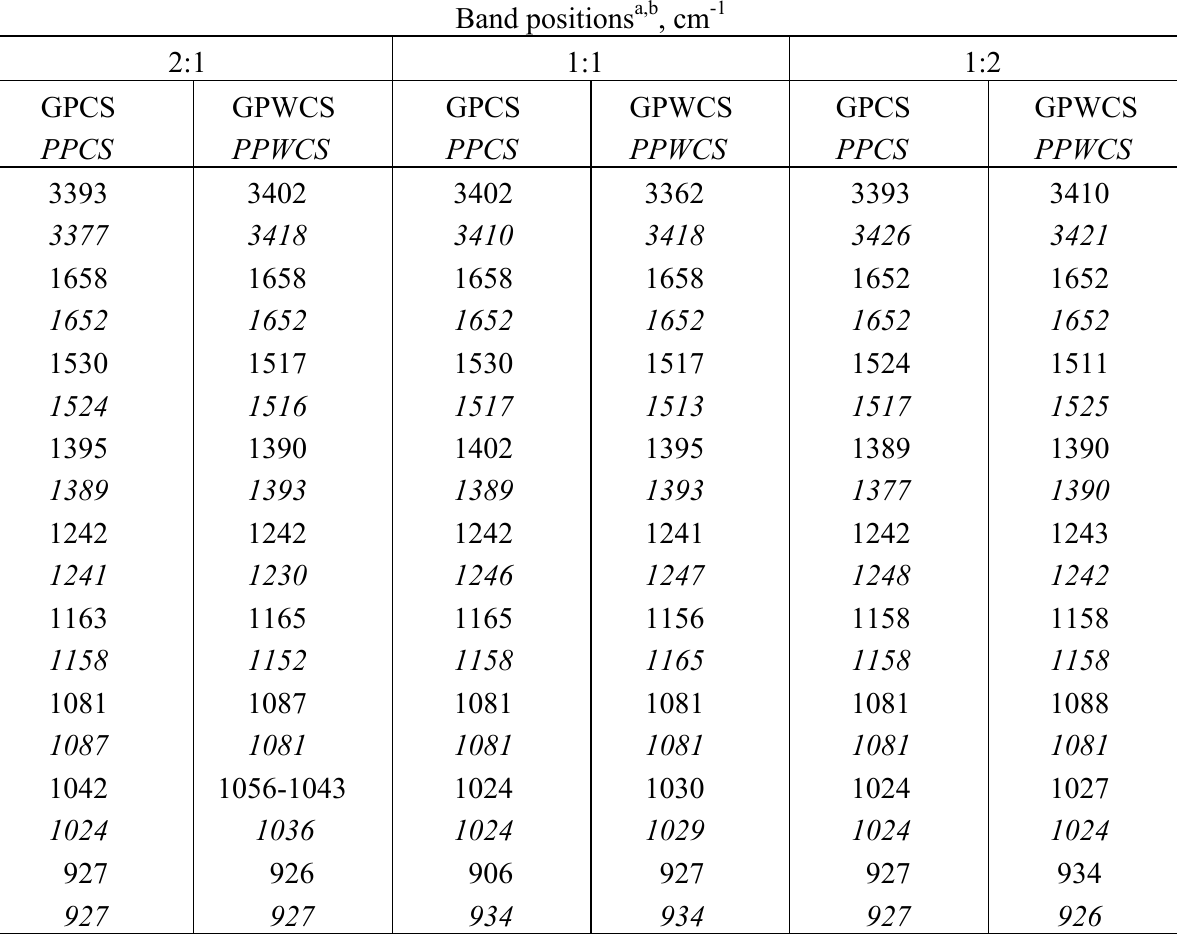
Table 5. IR spectral characteristics of casein complexes with GPCS, PPCS, GPWCS and